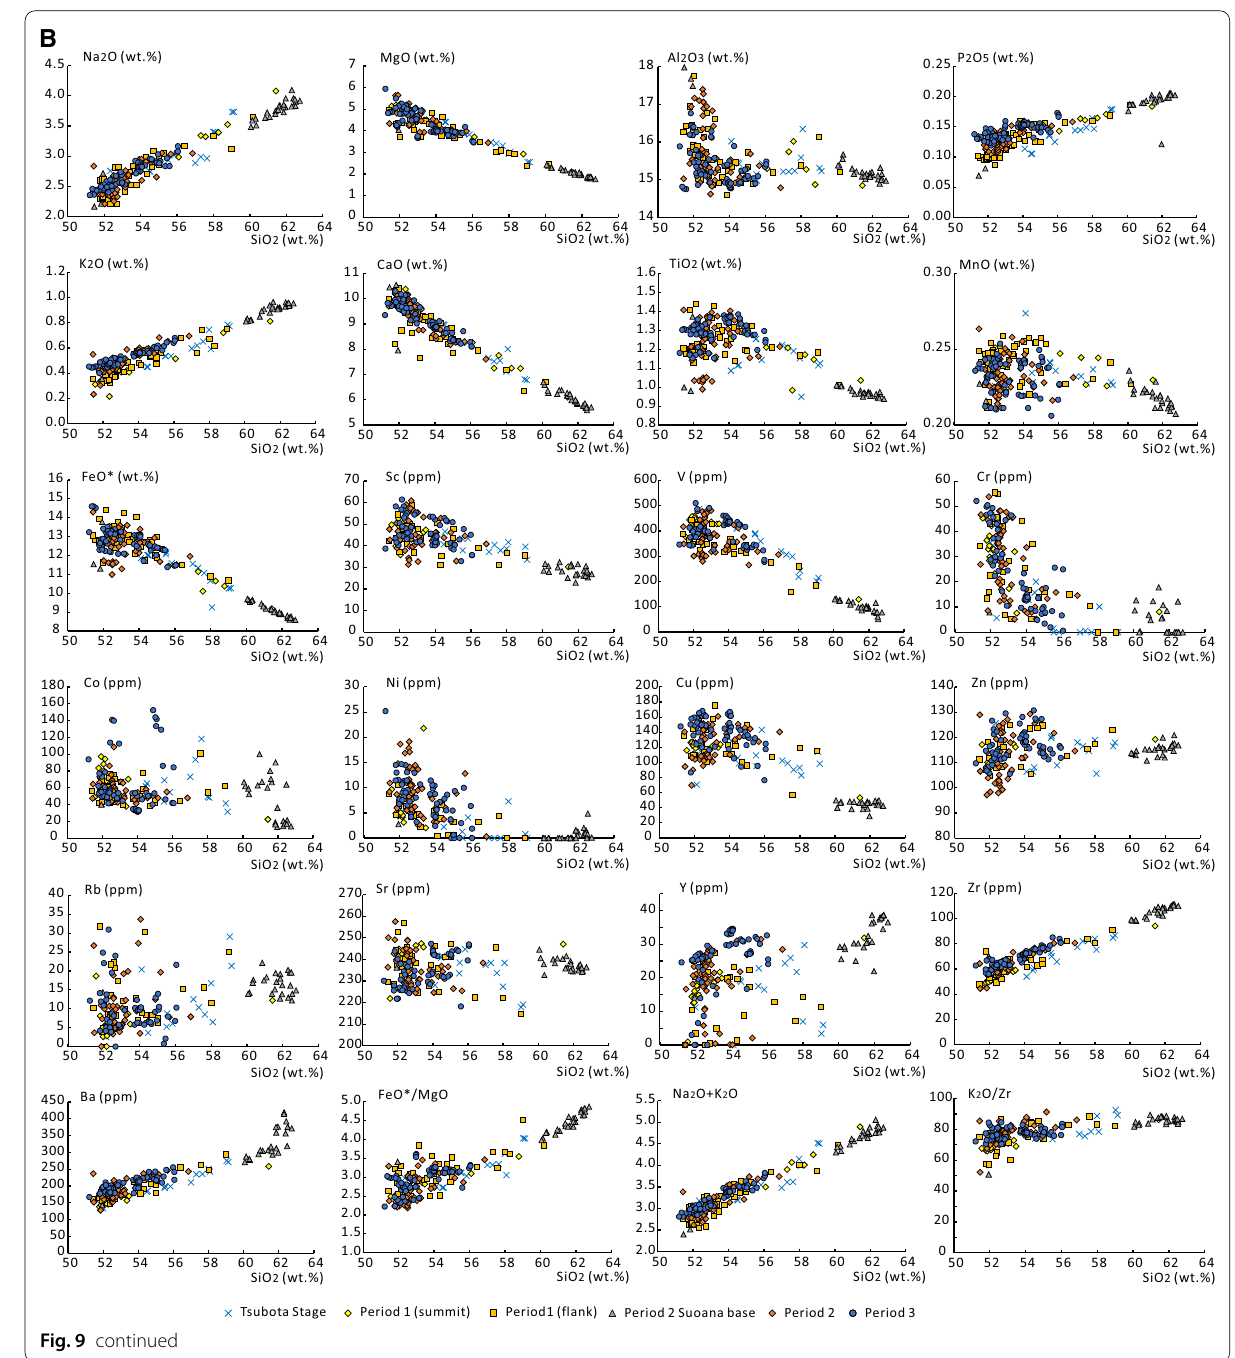
figure on next Fig. 10 Temporal change of the whole-rock compositions of the erupted magmas in Periods 1, 2 and 3. The vertical line shows the timing of the 1874AD eruption. All plotted data are normalized as total 100%. Only aphyric ejecta of the Suoana–Kazahaya eruption are plotted to eliminate the effect of xenocryst contamination. The eruption ages younger than the seventeenth century are based on historical records. The eruption ages older than the sixteenth century are given as calibrated ages using the IntCal 20